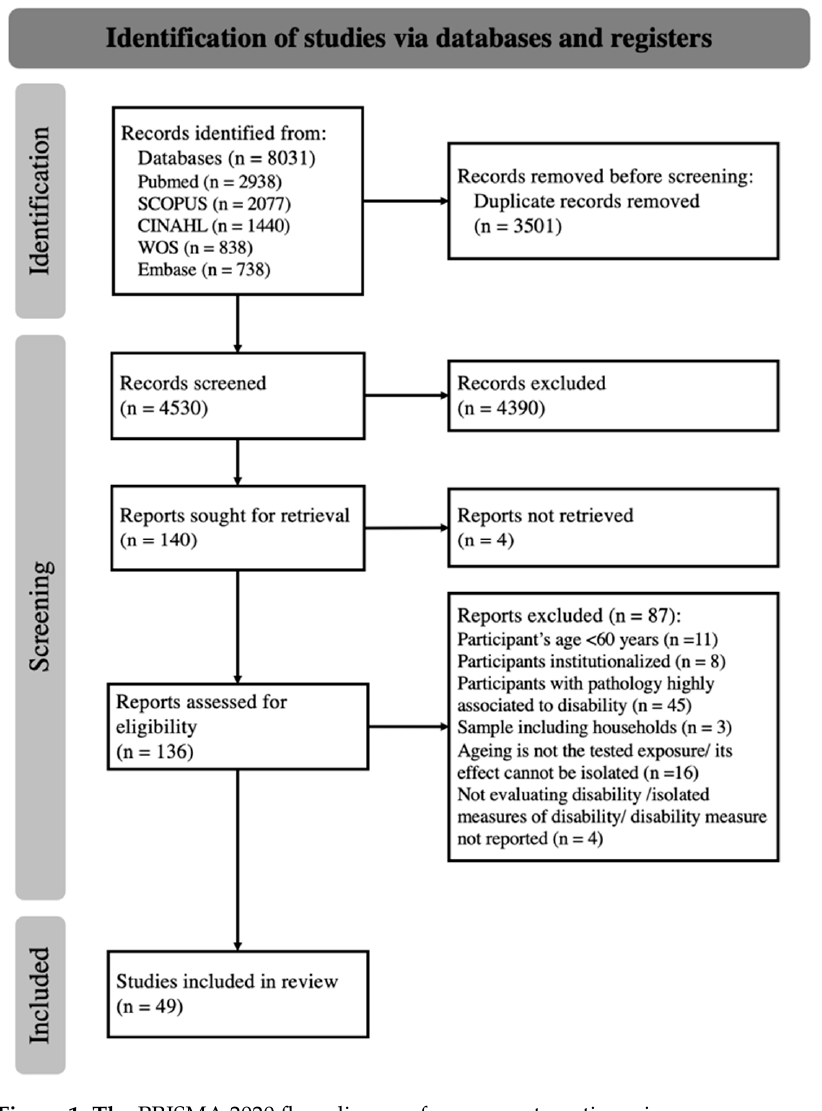
Figure 1. The PRISMA 2020 flow diagram for new systematic reviews.